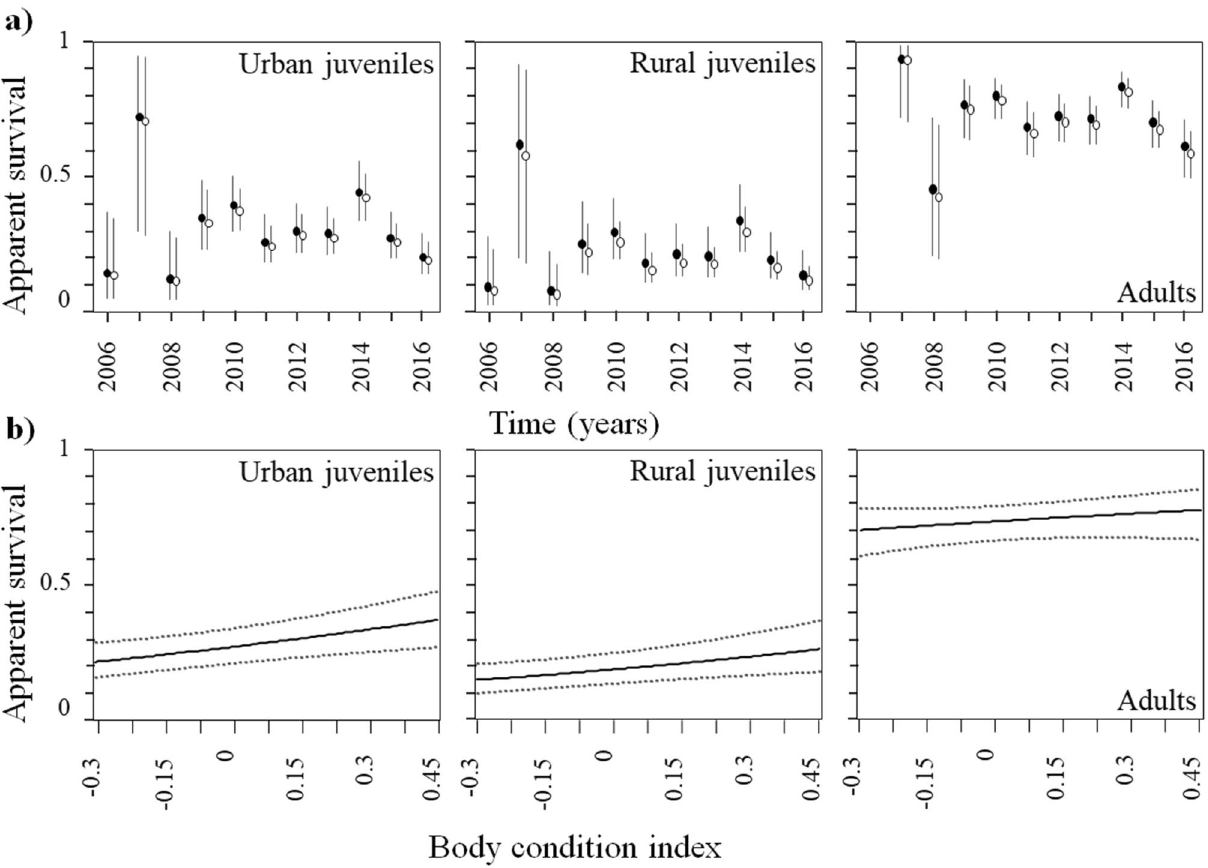
Figure 4. Model averaged (± 95% CI; bars and dotted lines) estimates of apparent survival probabilities for urban and rural juvenile and adult burrowing owls Athene cunicularia ( a ) raised in family units (black dots) and breeding pairs (white dots), and ( b ) in relation to individual body condition as chicks (we used the estimates for 2013 to plot the